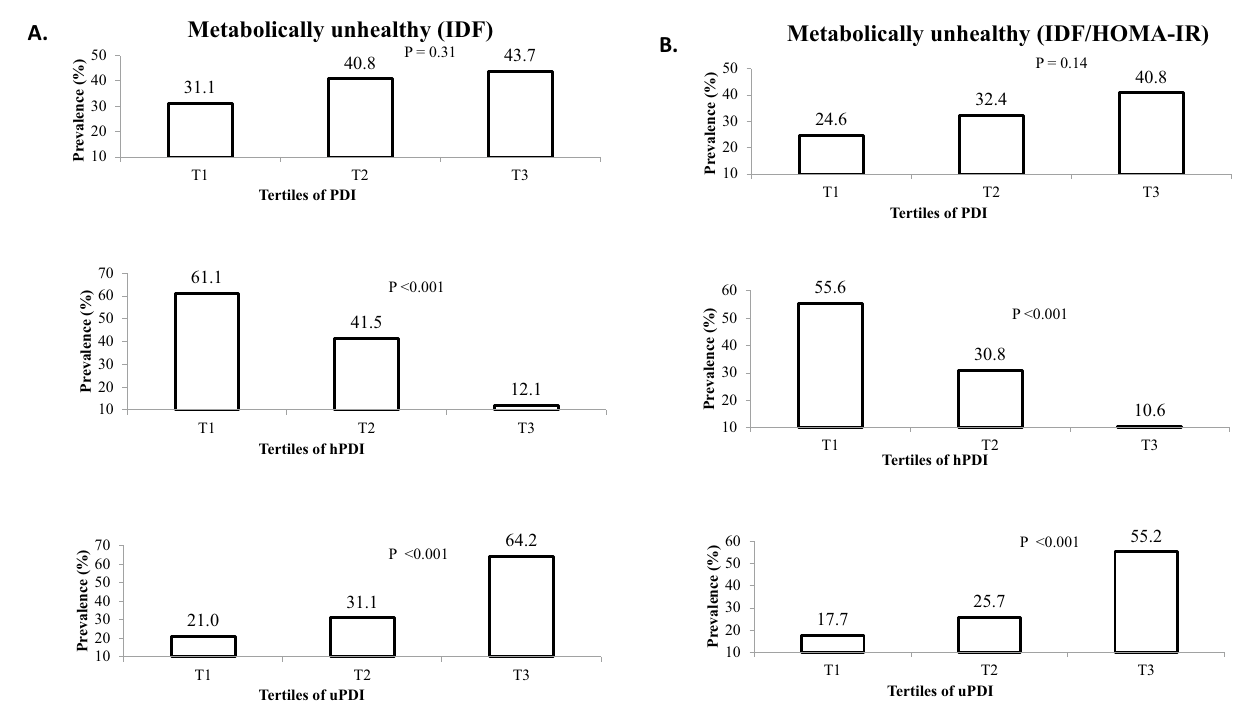
Figure 1. Prevalence of MUO across tertiles of PDI, hPDI and uPDI. ( A ) Based on IDF definition, ( B ) based on IDF/HOMA-IR